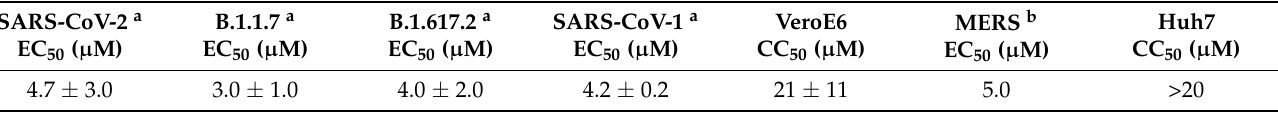
Table 5. Spectrum of antiviral activity of compound 1